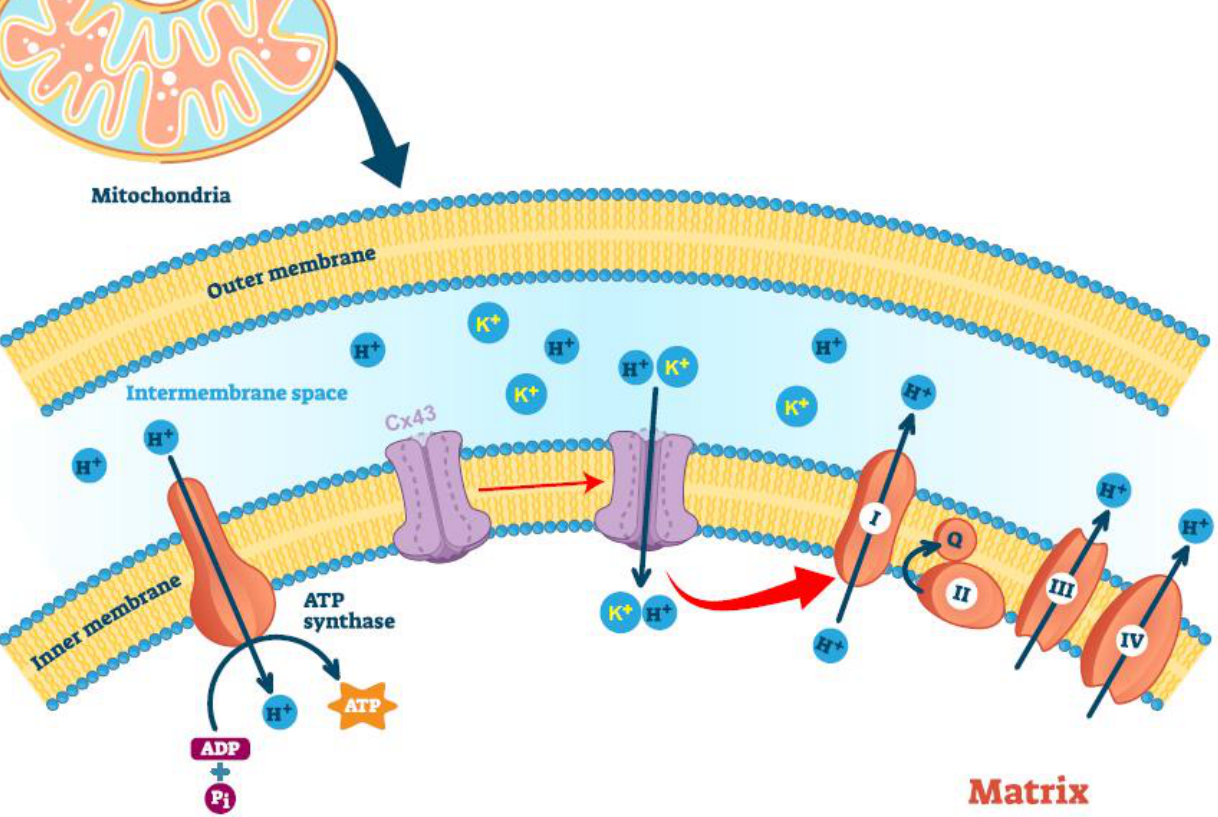
Figure 2. Mitochondria-localized Connexin43 forms a function hemichannel and may regulate po- tassium uptake, mitochondrial uncoupling, and ROS production. Cx43 forms a function hemichannel on mitochondrial inner membrane with C-terminal tail facing the intermembrane space. The mtCx43 channel is expected to let potassium and protons go through in a regulated way, which would in turn regulate mitochondrial integrity, Complex I respiration and ROS generation.